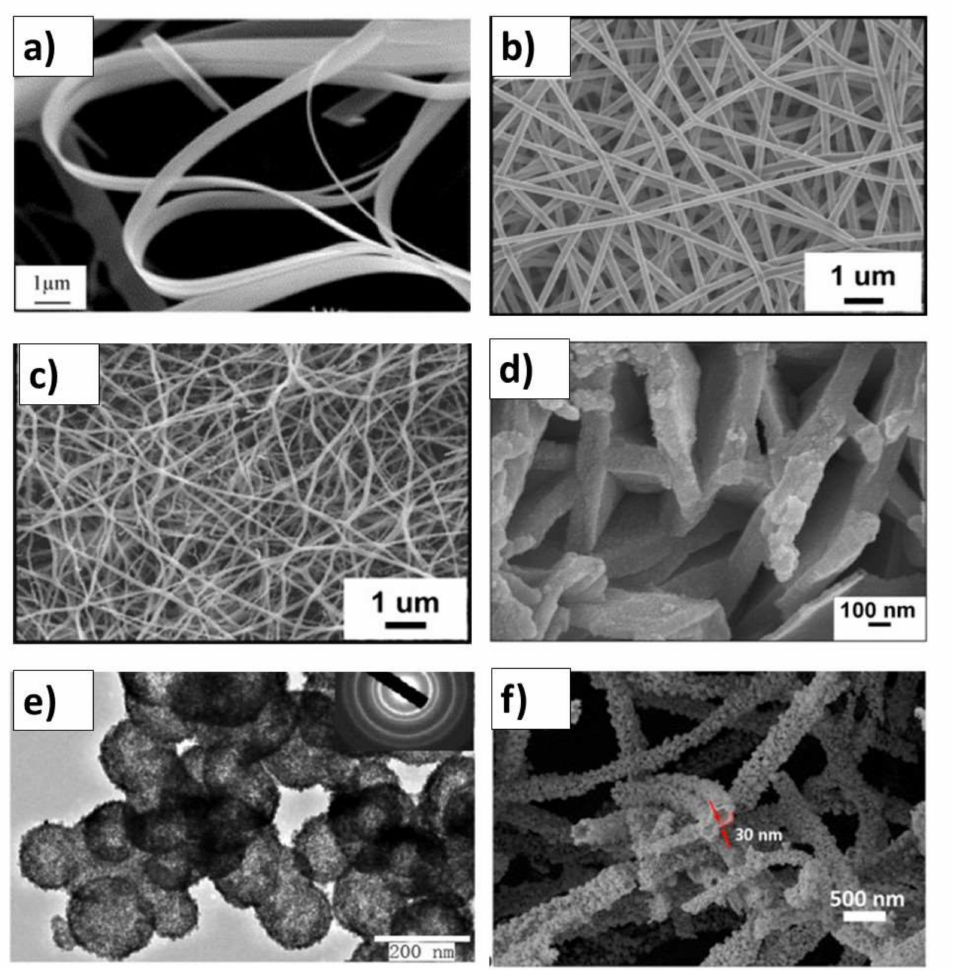
Figure 8. ( a ) SnO 2 nanobelts, ( b ) SnO 2 nanofibres, ( c ) SnO 2 nanowires, ( d ) SnO 2 nanoplates, ( e ) SnO 2 hollow nanospheres, ( f ) SnO 2 porous nanotubes. Adapted from references [89–93]. Copyright 2003, 2009, 2011, 2013, 2020 Elsevier. The precipitation through the solvothermal treatment is a simple and